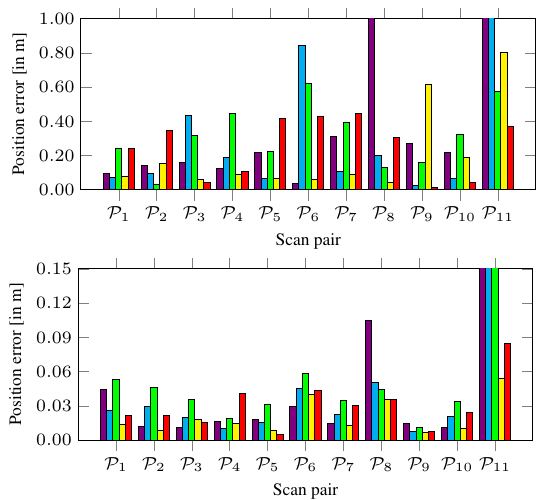
Figure 4. Position errors after the coarse registration (top) and af- ter the fine registration (bottom) of scan pairs P j = {S j , S j +1 } : SIFT (violet), SURF (cyan), ORB (green), A-KAZE + M-SURF (yellow), SURF ∗ + BinBoost (red).